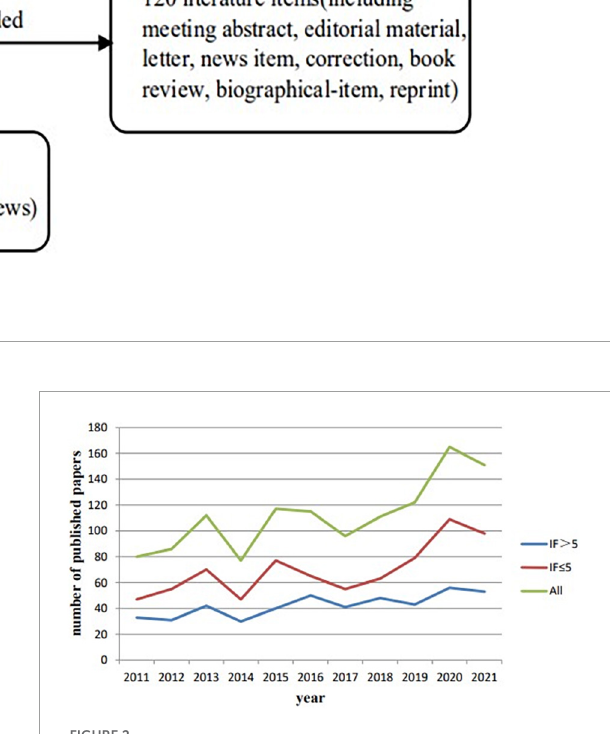
FIGURE2 Annual trend chart of publications related to Tourette Syndrome (TS) in children research from 2011 to 2021.